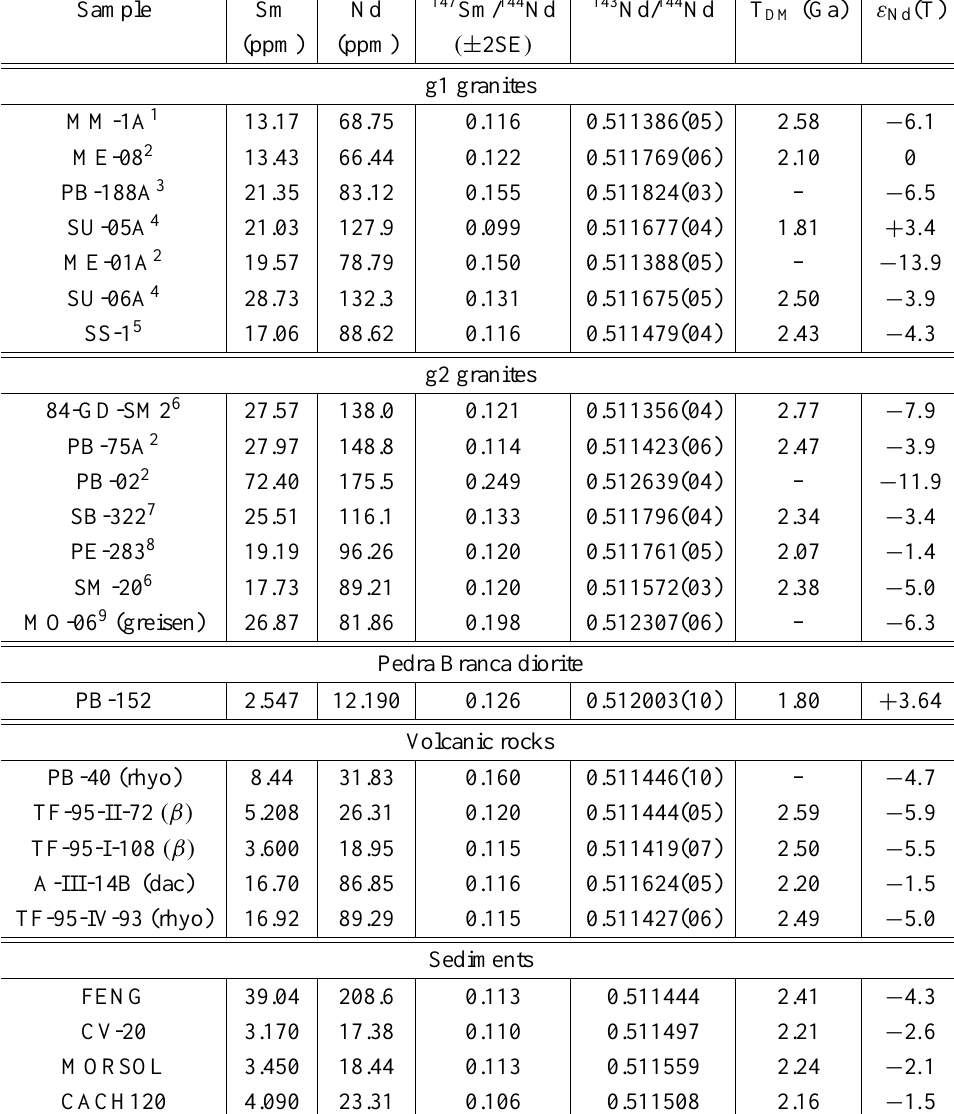
Nd isotopic composition for the Araí rocks and A-type